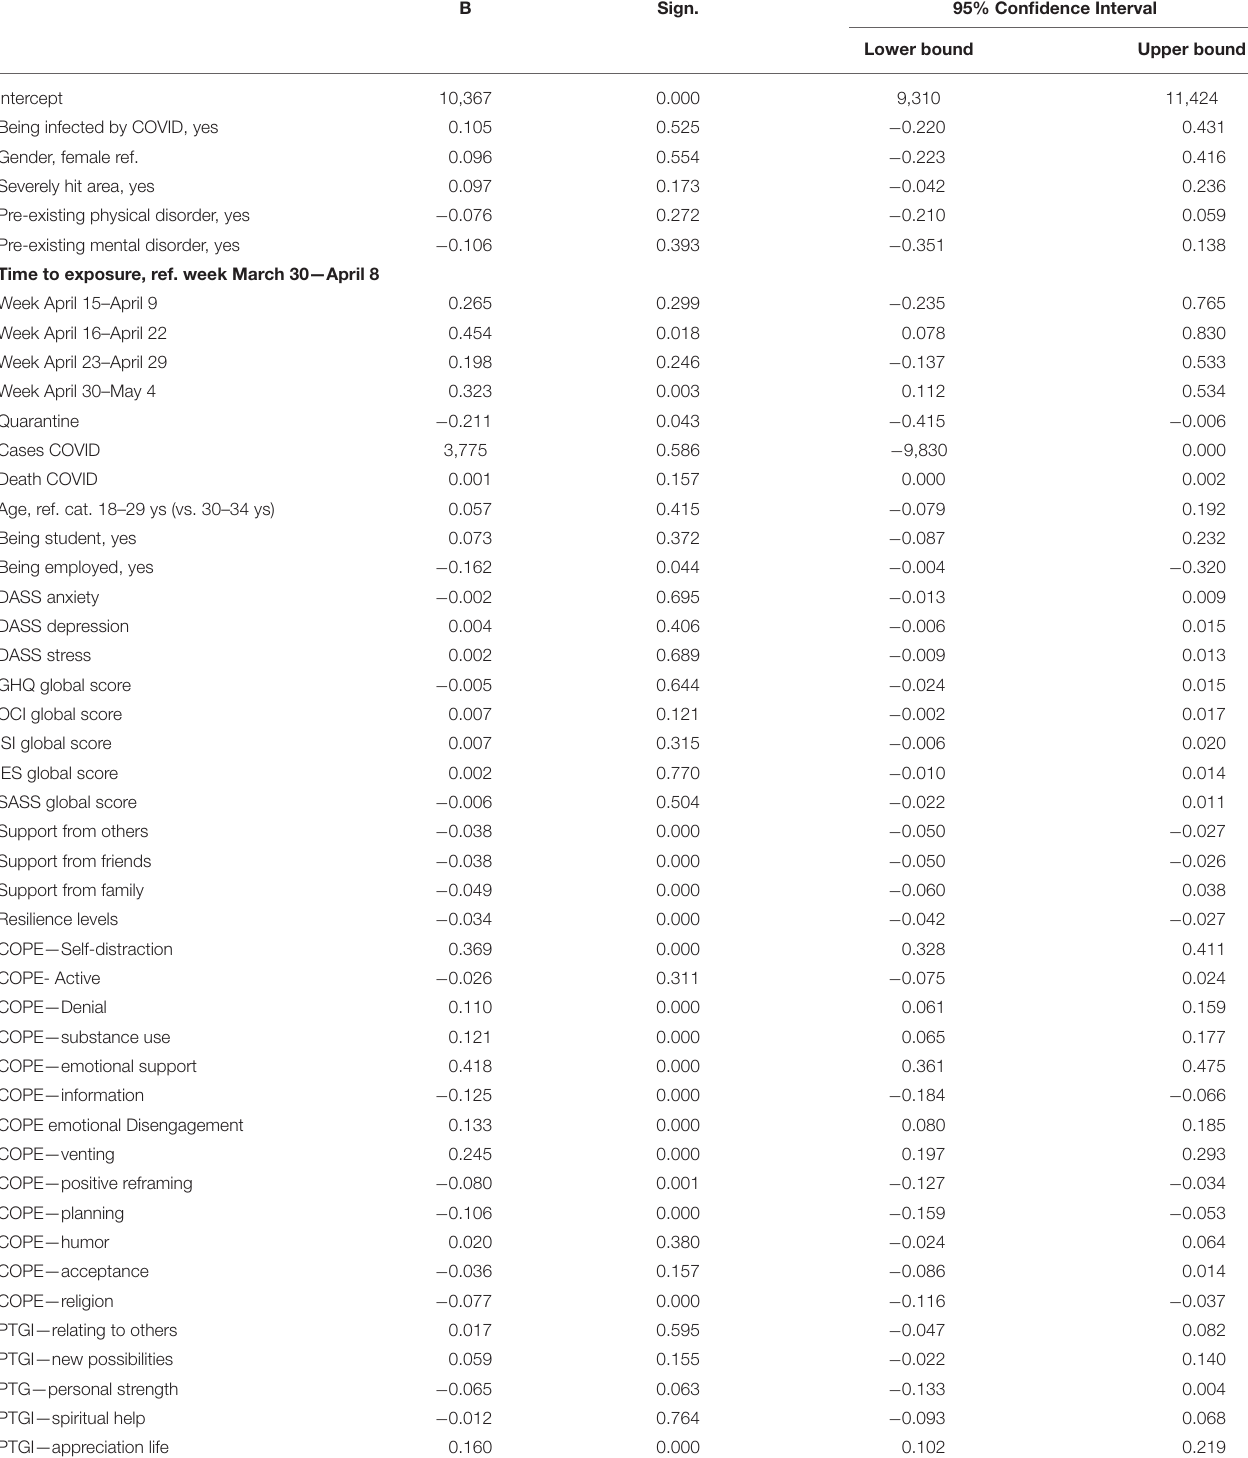
TABLE 3 | Predictors of the levels of loneliness. B Sign. 95% Confidence